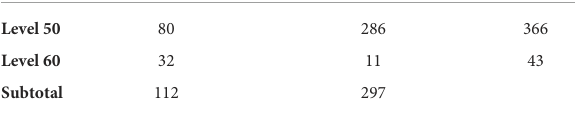
TABLE 1 Demographic information of test takers from 2009 to